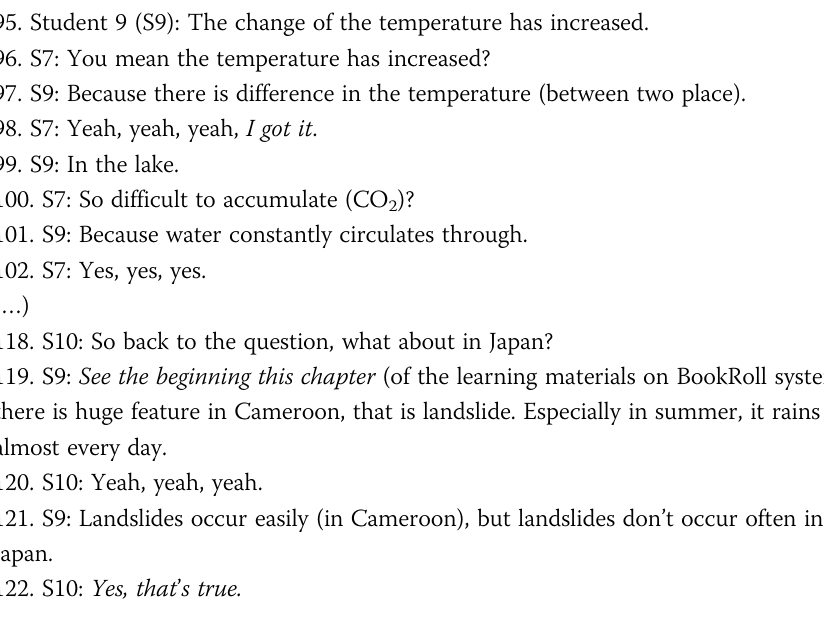
Table 9 Elements and indicators in perspective taking and social regulation Factor Element Indicator Perspective Adaptive responsiveness Ignoring, accepting, or adapting contributions of others taking Audience awareness (mutual modeling) Social regulation